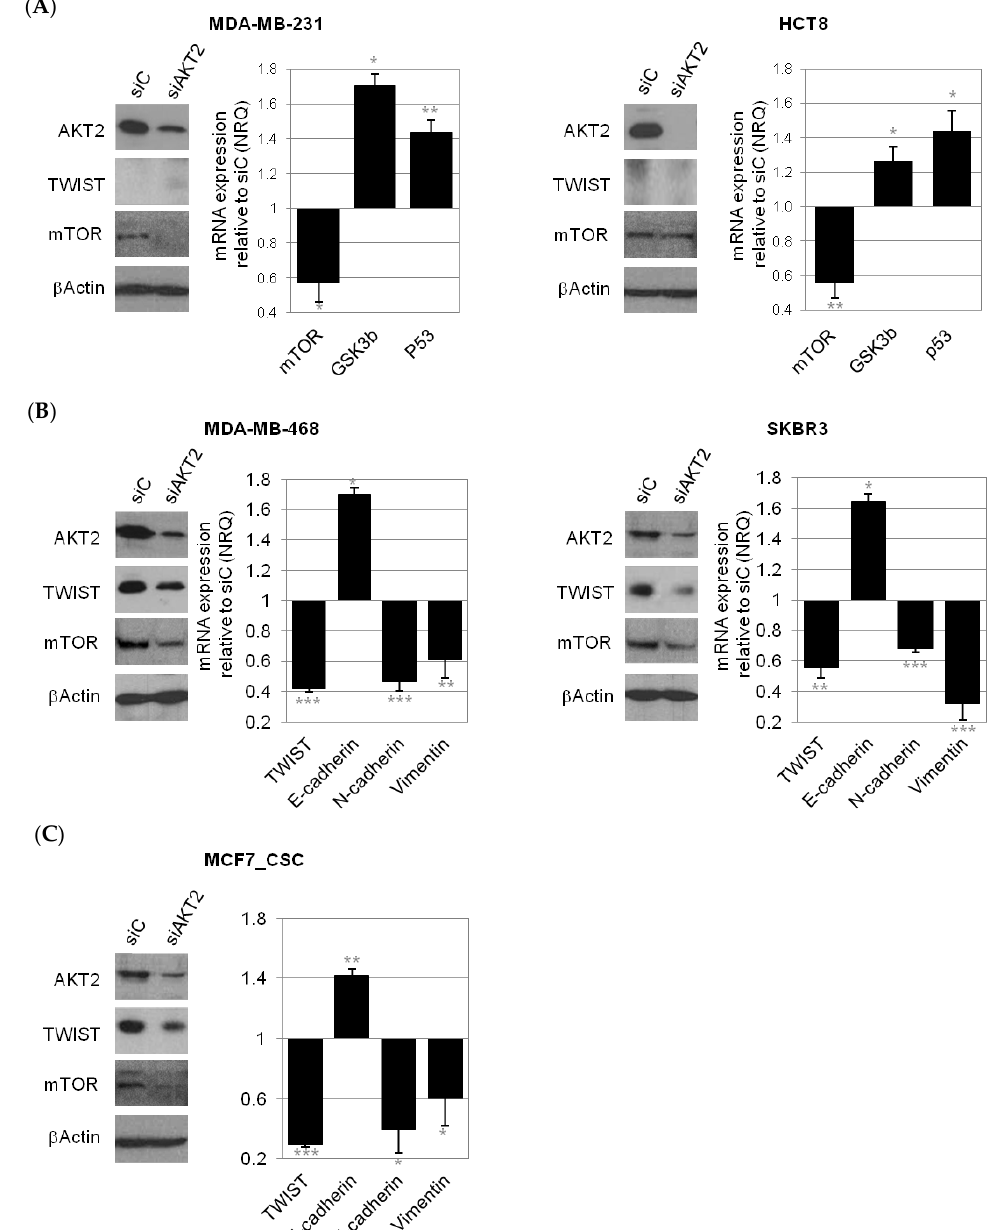
Figure 7. AKT2 silencing on gene expression. qPCR quantification of gene expression levels of key regulators in the mTOR signaling pathway in cells that do not express TWIST (MDA-MB-231, HCT8; ( A ) and epithelial-to-mesenchymal transition (EMT) signaling pathway in mesenchymal cells that do express TWIST (MDA-MB-468, SKBR3; ( B ) and (MCF-7 CSC) after the treatment with siAKT2 ( C ). The presented values are relative to cells transfected with siC and are expressed as NRQ (relative normalized quantities) mean ± SEM ( n ≥ 3); (* p < 0.05; ** p < 0.01, *** p < 0.001).